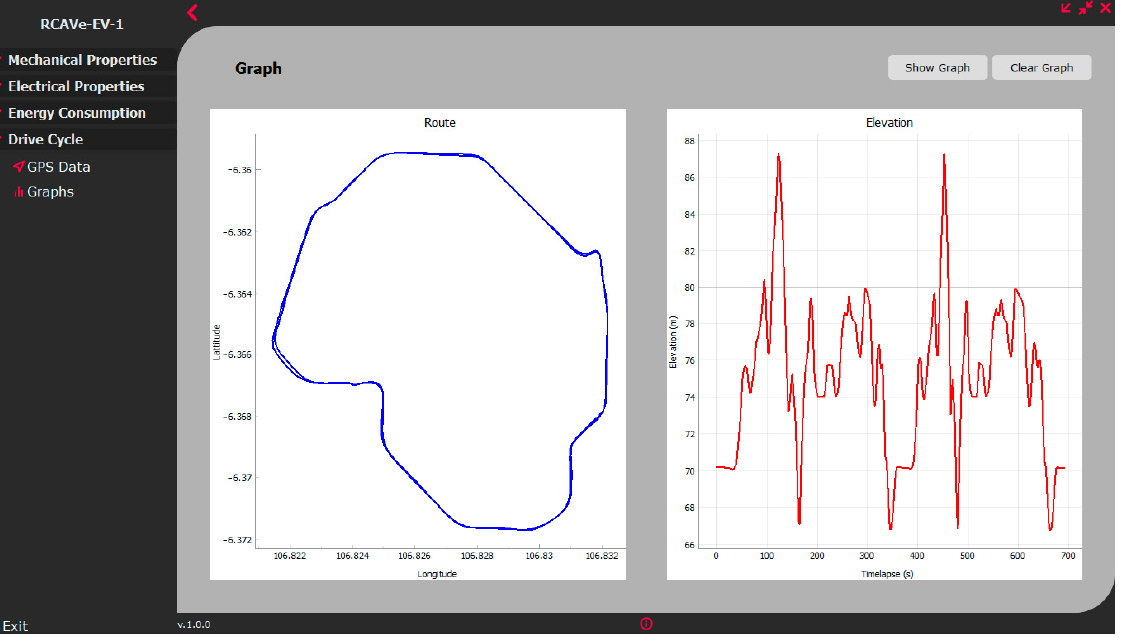
Figure 5. GPS data remapping results—two turns (route and elevation).